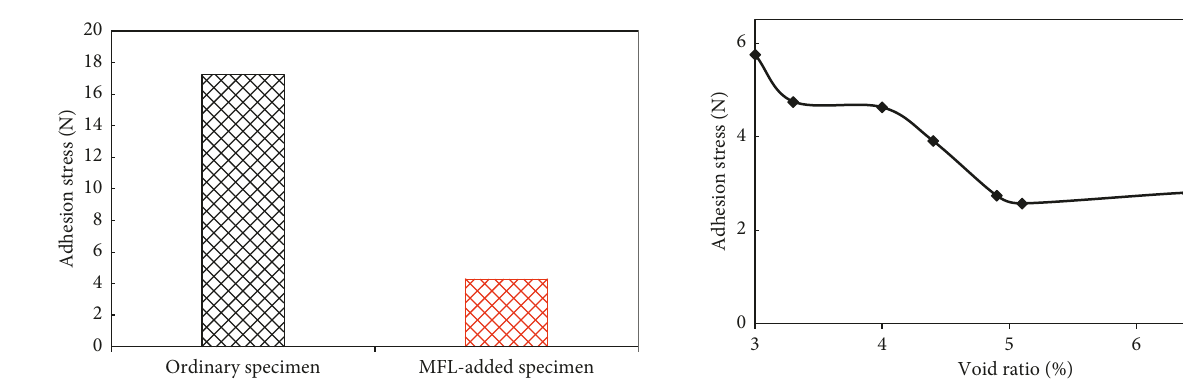
Figure 15: Adhesion variation with void